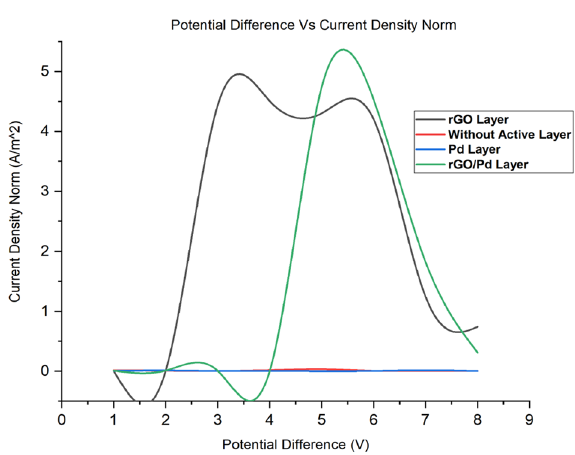
Figure 8. Effect and comparison of V–I response of all four chemical gas sensor i.e., SnO 2 thin film, SnO 2 –Pd, SnO 2 –rGO & SnO 2